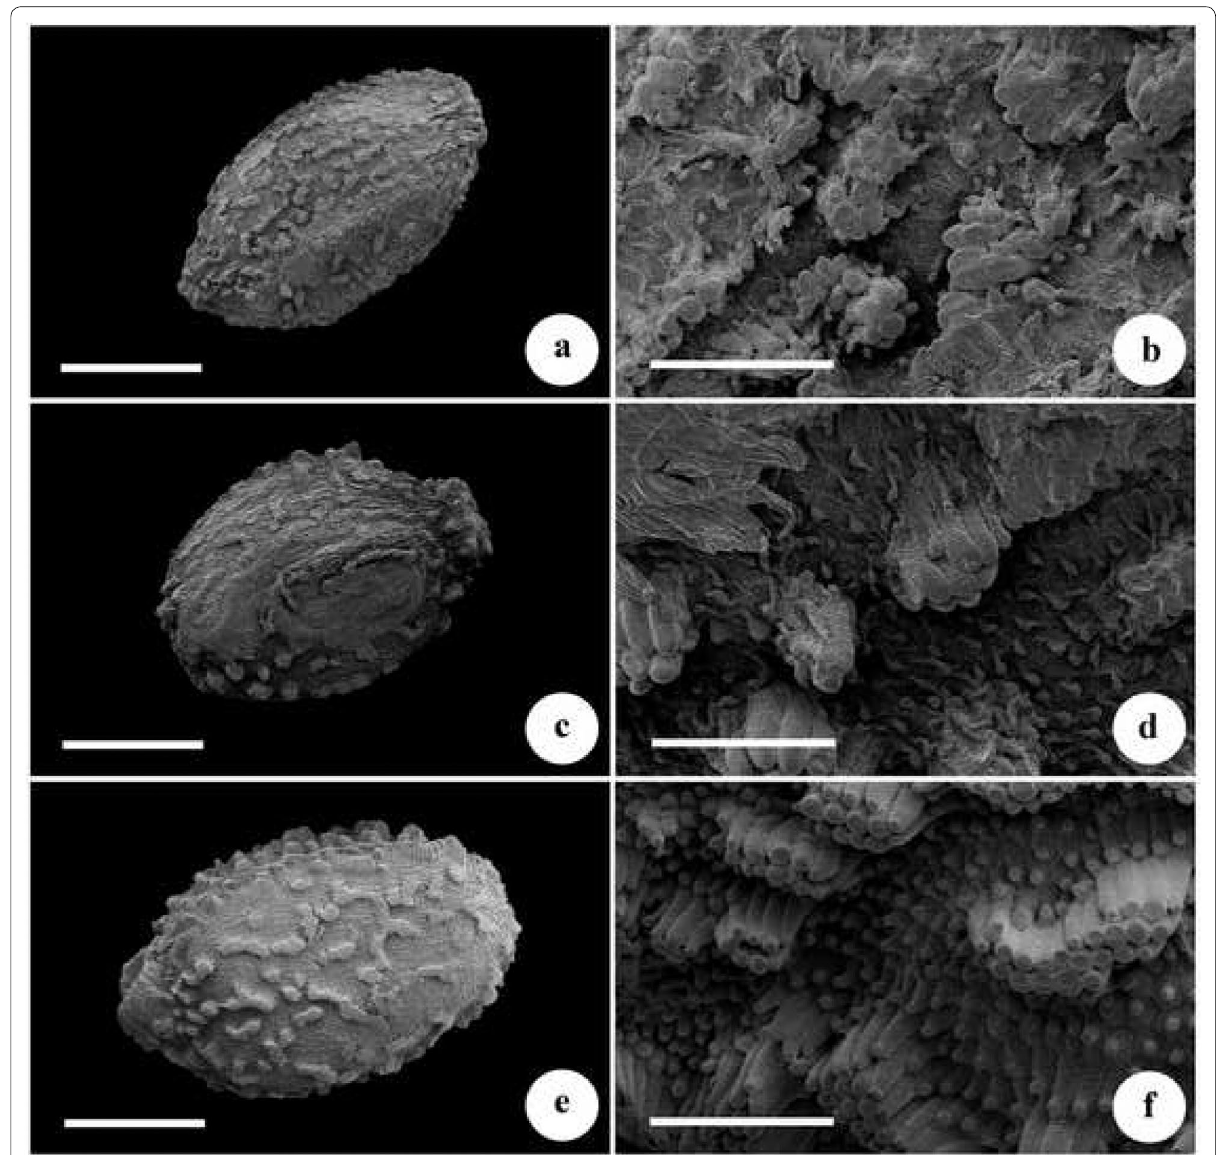
Fig. 2 Micromorphology of seeds of Impatiens wuyiensis , I. platysepala and I. chloroxantha . a, b I. wuyiensis ; c, d I. platysepala ; e, f I. chloroxantha . a, c, e shape of seeds (scale bar: 1 mm); b, d, f surface ornamentation of seedcoat (scale bar: 200